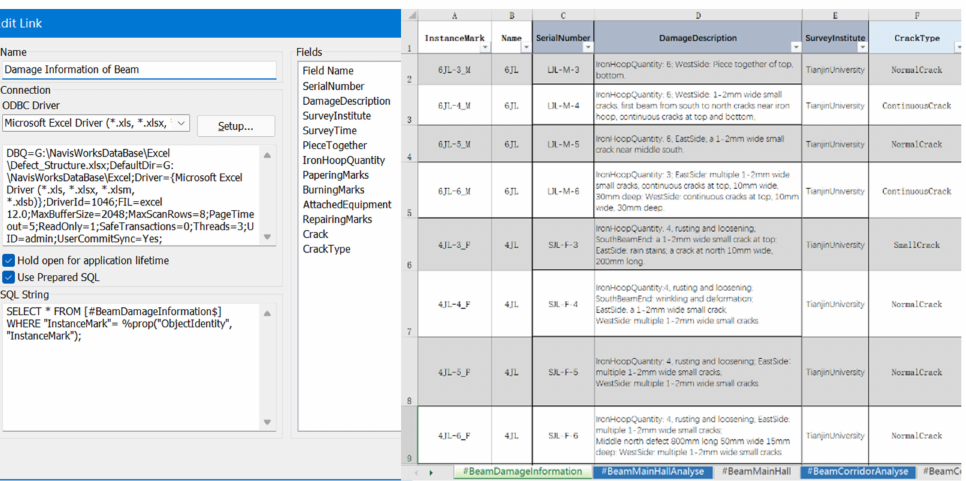
Figure 20. The SQL statement in Navisworks ( left ) correlating with the database of damage states ( right